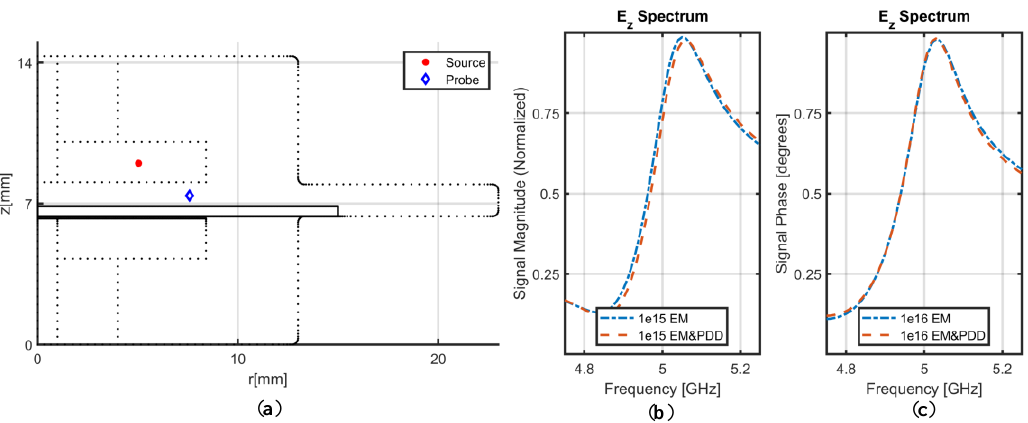
Figure 4. ( a ) Source and probe locations shown on the axisymmetric representation of the resonator; ( b ) spectrum obtained through EM solver and EM-PDD coupled solvers for a Si sample with n-type doping 10 15 cm −3 ; ( c ) spectrum obtained through EM solver and EM-PDD coupled solvers for a Si sample with n-type doping of 10 16 cm −3.